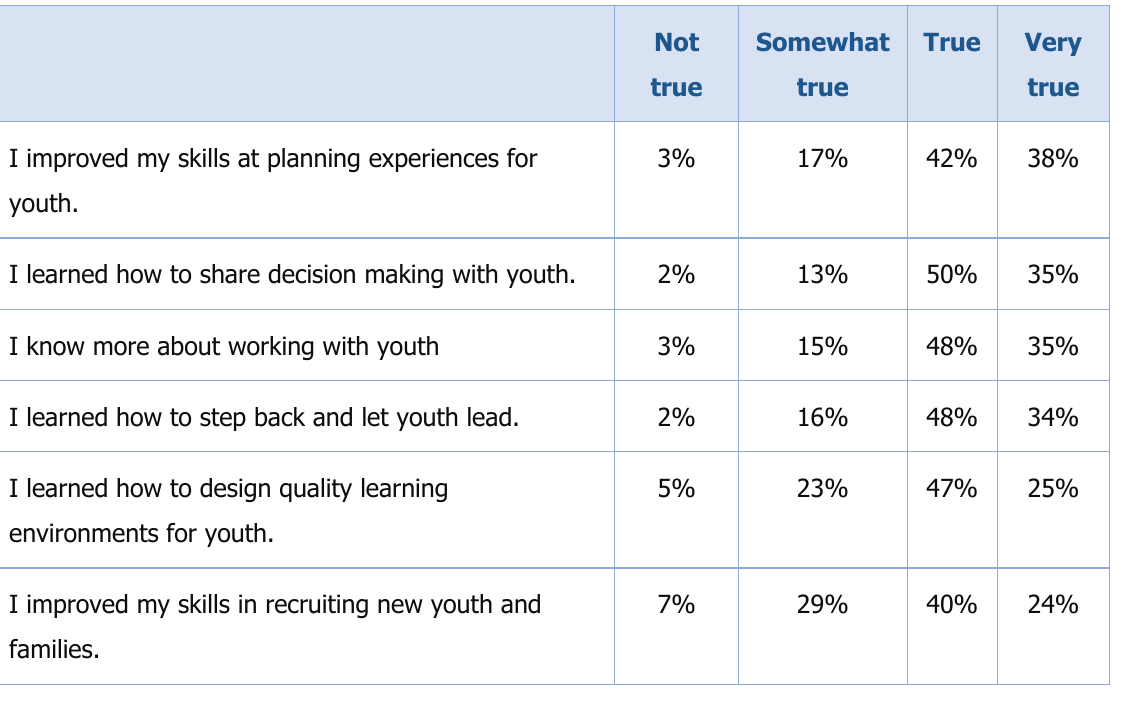
Table 2. Positive Youth Development Benefits